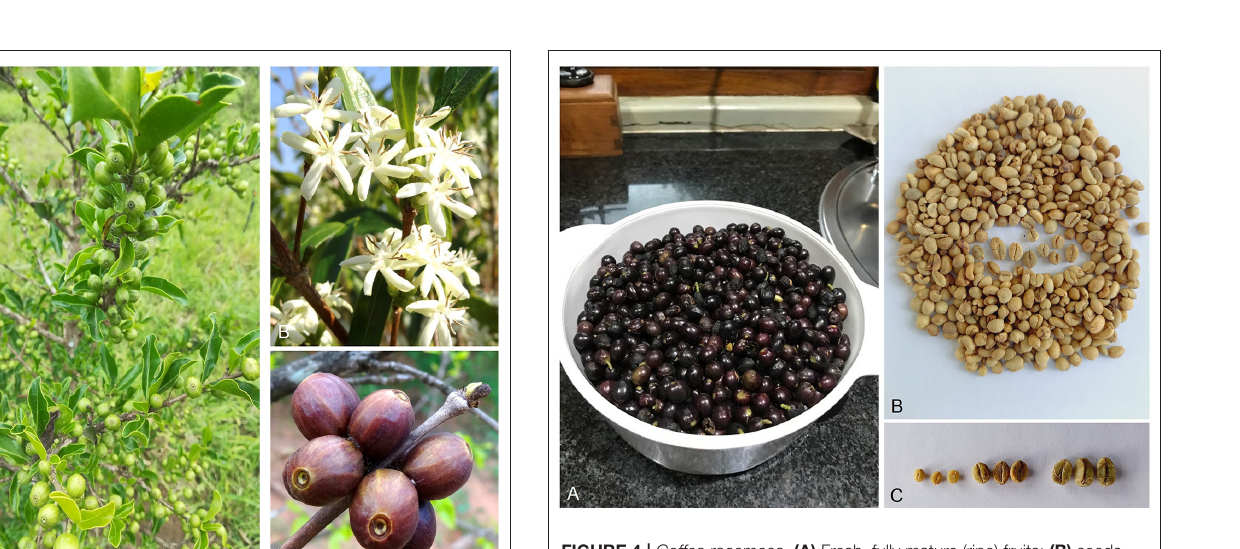
FIGURE 4 | Coffea racemosa . (A) Fresh, fully mature (ripe) fruits; (B) seeds, showing variation in size; (C) seeds (left to right) of Coffea racemosa , compared to C. canephora (robusta) and C. arabica (Arabica). Images: (A) Charles Denison); (B,C) Aaron